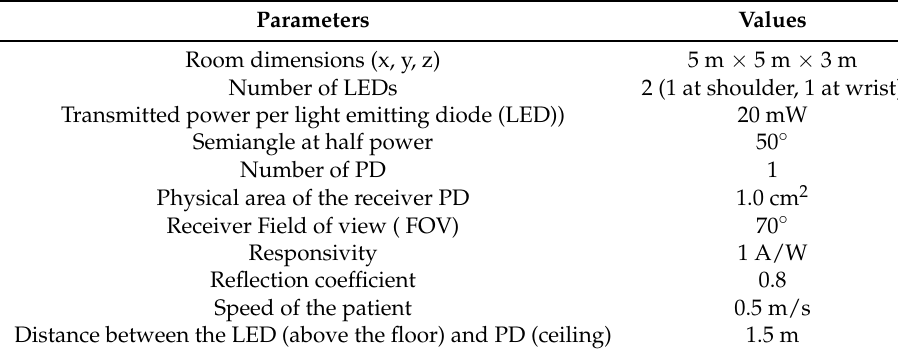
Table 1. Simulation